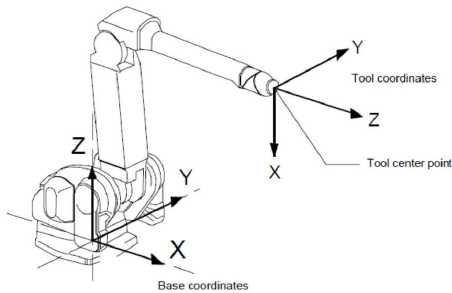
Figure 2: General structure of a robotic